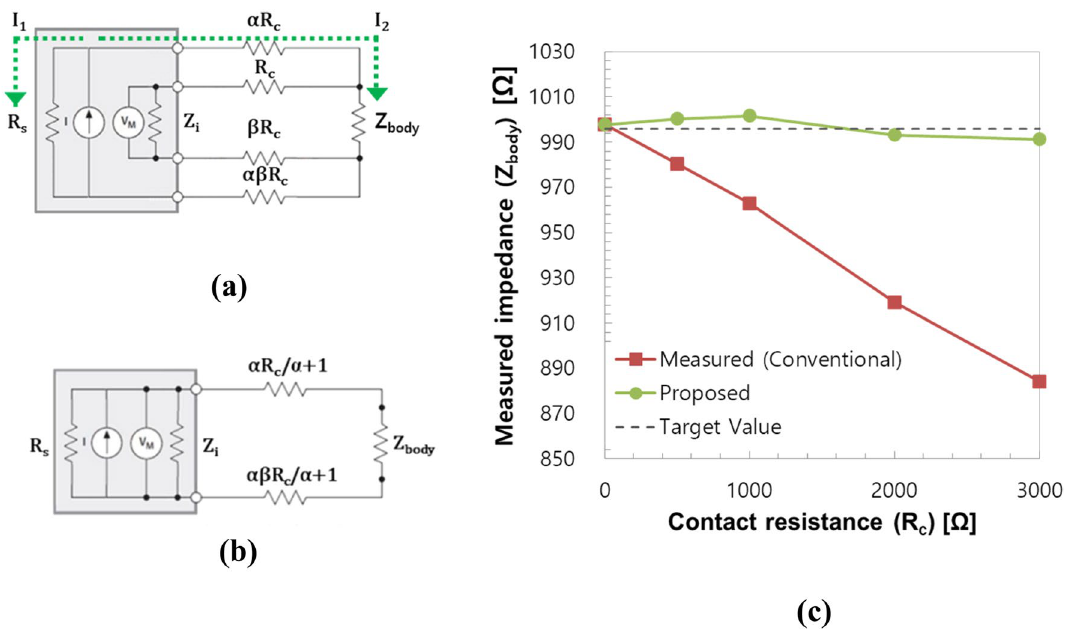
Figure 3. Contact resistance compensation method. ( a ) 4-point measurement mode, ( b ) 2-point measurement mode, and ( c ) contact resistance compensation effect. (| Z body |= 1 kΩ, | Z i |= 2 MΩ, R s = 50 kΩ). Z body measured impedance, Z i input impedance of the voltmeter, R s output impedance of the current source, R c contact resistance, I current, V M measured voltage, α the size ratio of voltage to current electrode, β the size ratio of finger to wrist